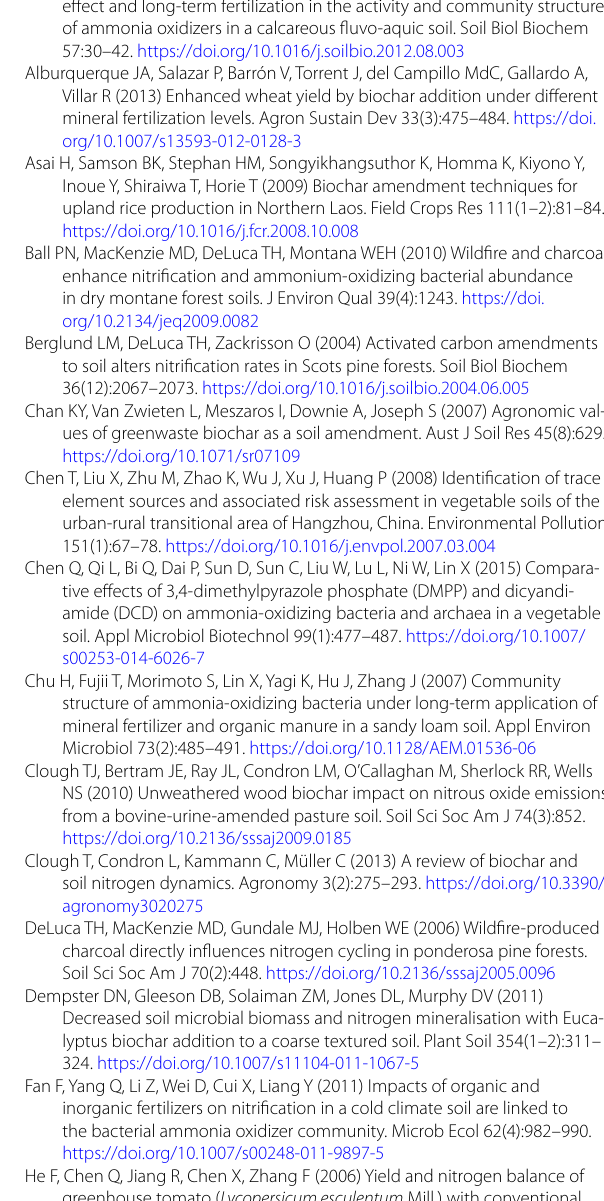
Additional file 1: Table S1. Primers of AOA and AOB used for molecular analyses. Table S2. Pearson correlation between the abundance of AOA/AOB and net nitrification rate. Table S3. Permutational multivari‑ ate analyses for the effects of different treatment (Treat) and